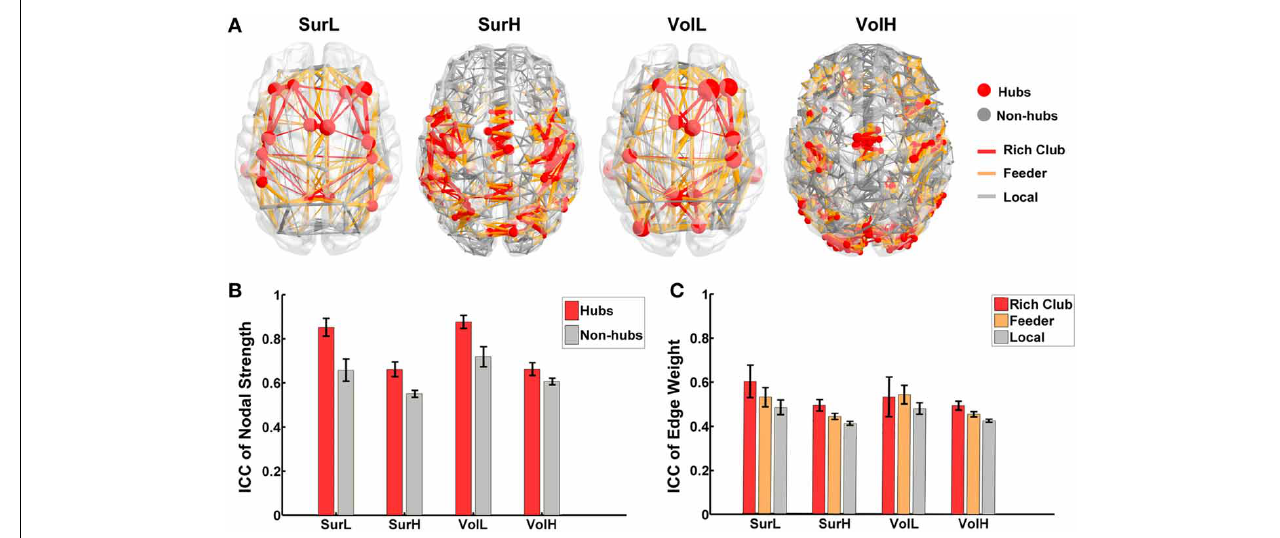
FIGURE 9 | The TRT reliability of rich-club organization. (A) The classification of hub/non-hub nodes and rich-club/feeder/local connections of WM networks constructed from different procedures. (B) The reproducibility of nodal strength of hub regions is significantly higher than the nodal strength of non-hub regions regardless of construction procedures. The bars and errorbars represent the mean values and standard errors, respectively, of the